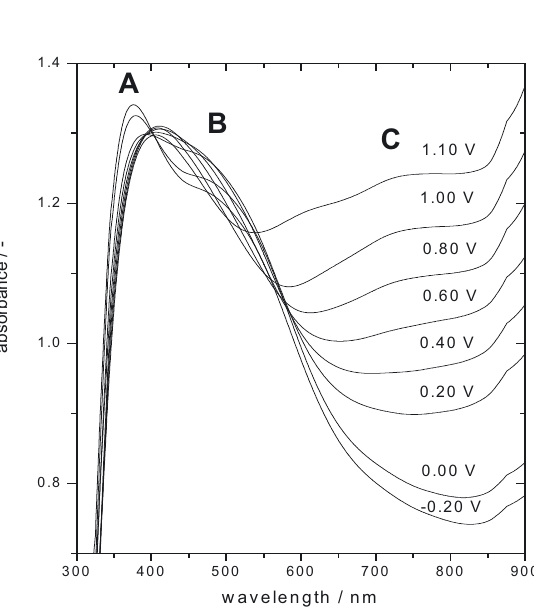
Figure 7. UV-Vis-spectra for P3MPy deposited potentiodynami- Figure 8. UV-Vis-spectra for poly(3MPy- β -DMCD) deposited potentio- cally by cycling the potentials from -0.20 < E dynamically by cycling the potentials from - 0.20 < E Ag/AgCl Ag/ AgCl < 1.10 V in solution of 0.038 M 3MPy in acetonitrile < 1.10 V in solution of 0.038 M poly(3MPy- β -DMCD) in + 0.05 M LiClO at different oxidation stages. at different oxidation acetonitrile + 0.05 M LiClO 4 4